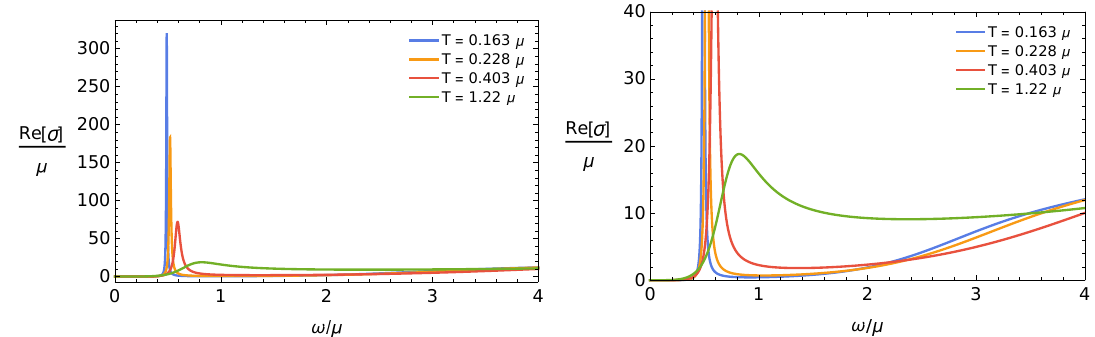
Figure 14. Real part of the optical conductivity for the Reissner-Nordstr(cid:127)om metal in d = 3 + 1 with a double-trace deformation ( (cid:11) 2 = 1 = 10). On the right we show an enlarged version of the (cid:12)gure on the left. We clearly see a peak at the plasma frequency, that becomes increasingly higher (left) and sharper (right) as we lower the temperature. Moreover, we notice that the conductivity goes to zero as ! ! 0, contrary to the neutral system.